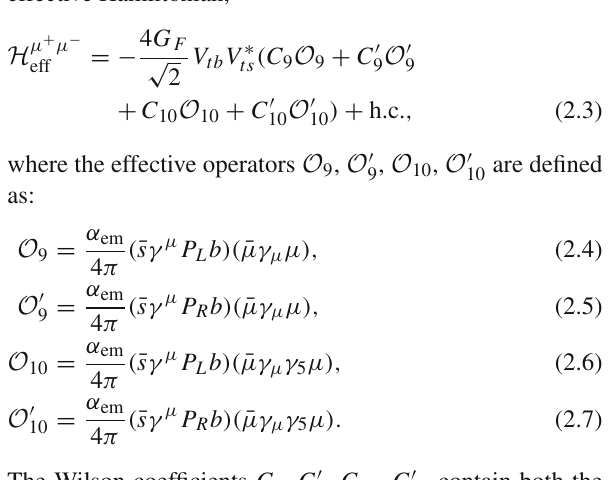
Fig. 1. These effects can be described using an effective